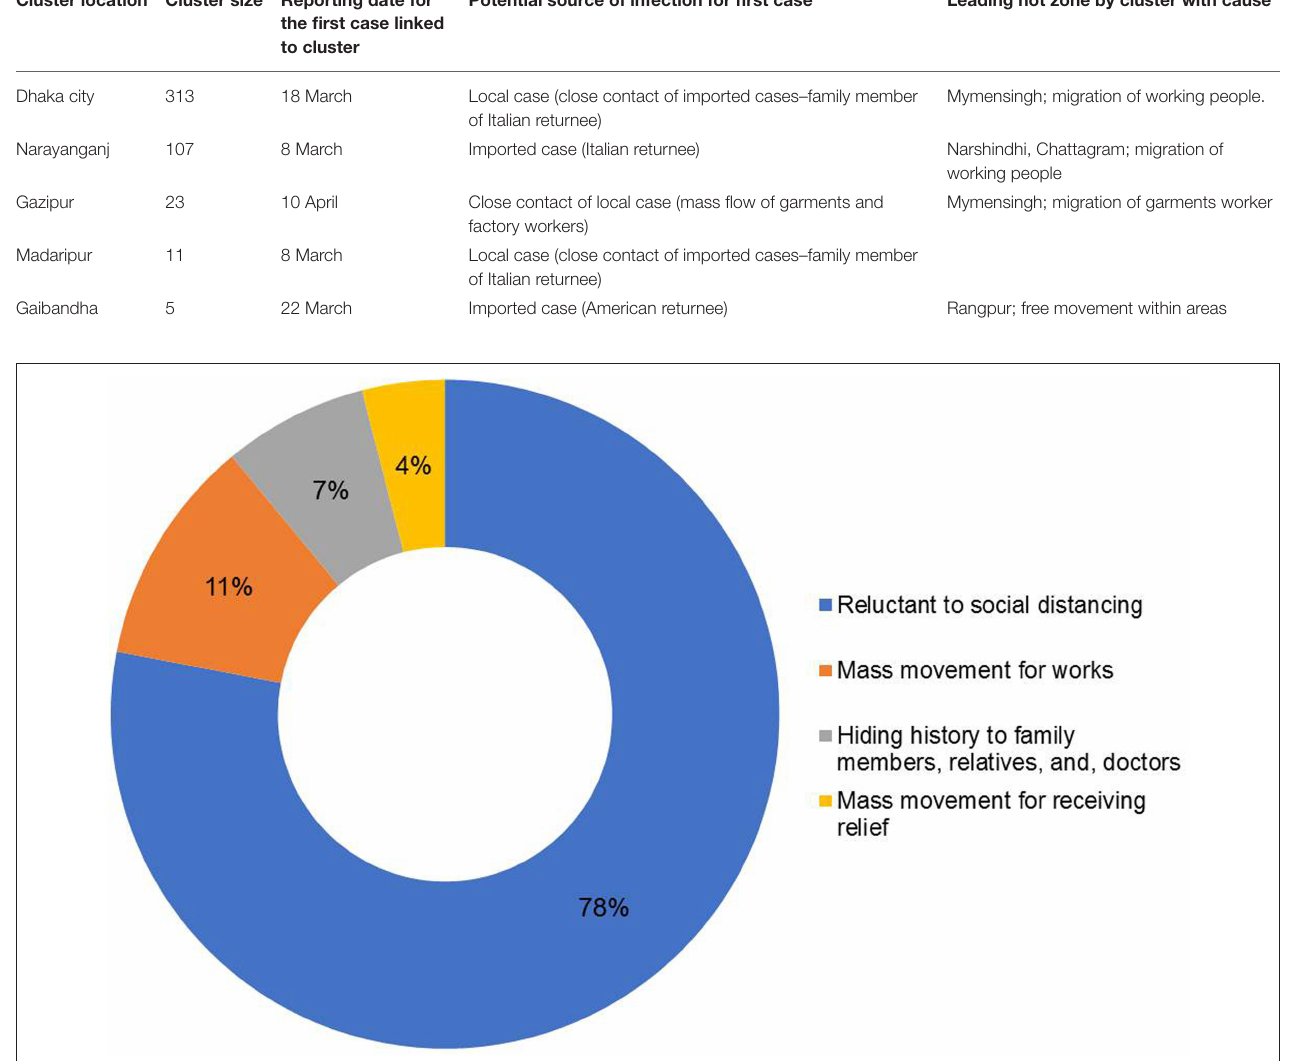
TABLE 5 | Characteristics of large clusters in Bangladesh as of 13 April 2020. Cluster location Cluster size Reporting date for the first case linked